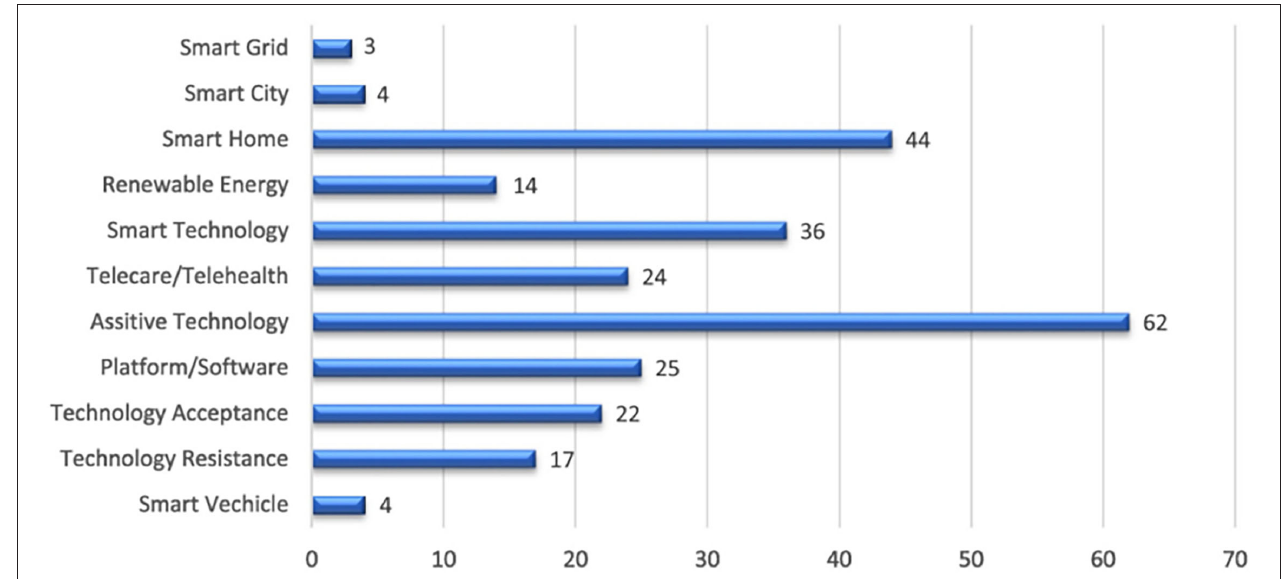
FIGURE 1 | Smart technology usage (Marikyan et al., 2019).